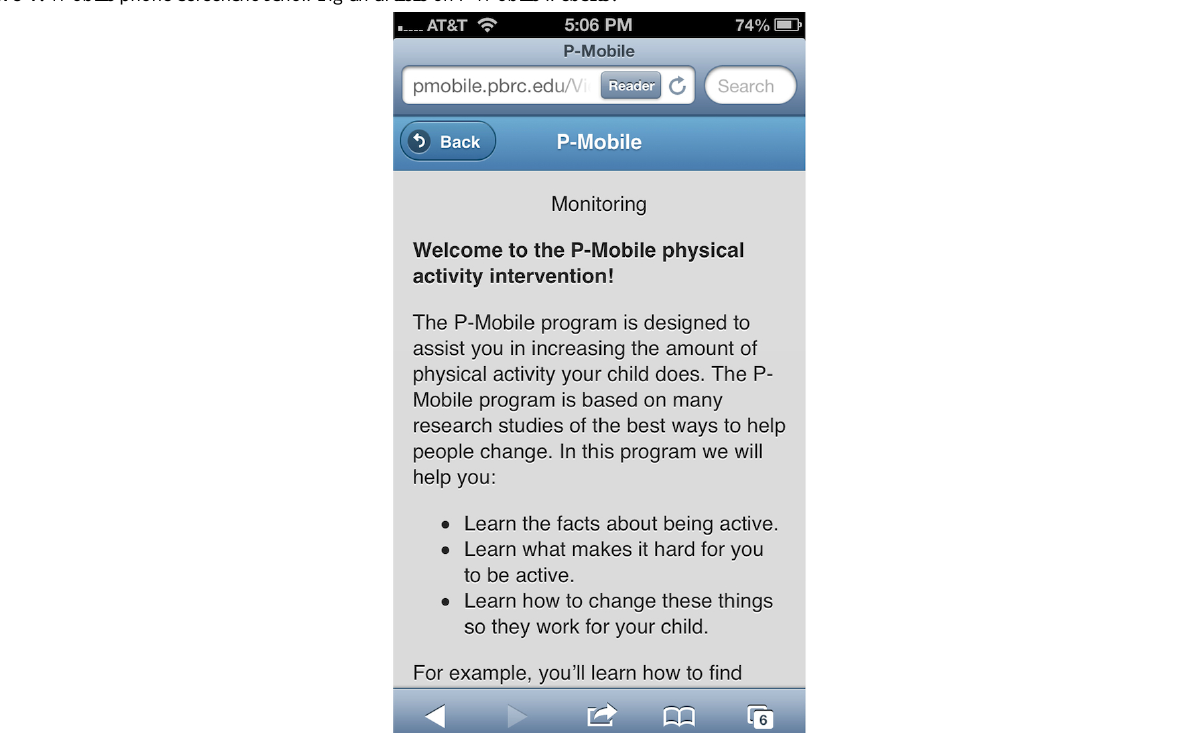
Figure 4. Mobile phone screenshot showing an article on P-Mobile